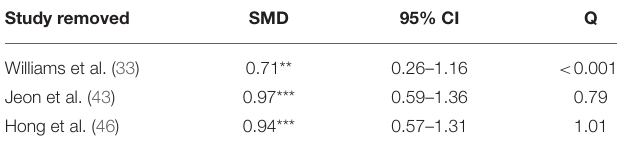
TABLE 3 | Summary of leave-one-out analysis.